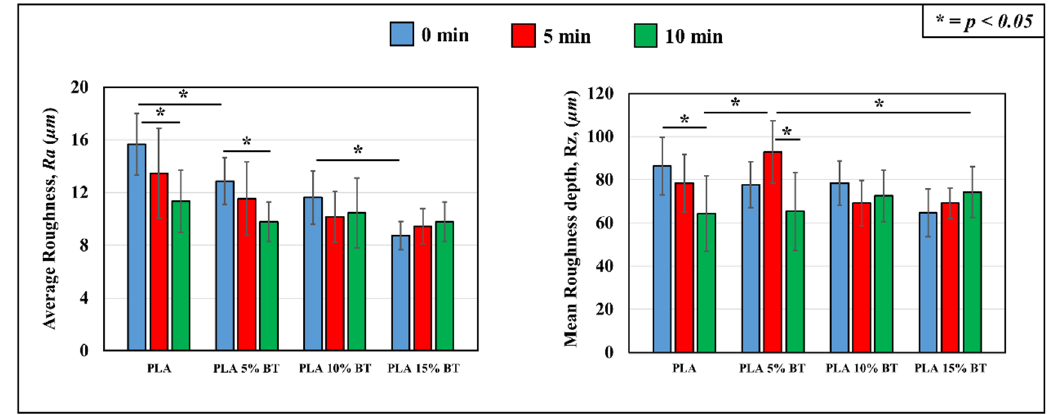
Figure 2. Comparison of roughness parameters, Ra and Rz of the substrates samples before and after treatment. The values are obtained by calculating the parameter in 25 images randomly acquired from each mapped surface using 150 ✕ of magnification.